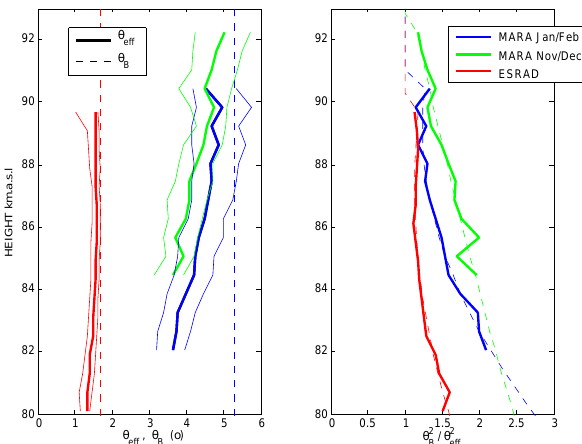
Fig. 1. Two-way antenna beam widths θ B (dashed lines), median (thick lines) and quartile (thin lines) height profiles of effective beam width θ eff (left-hand panel) and corresponding correction fac- /θ 2 tors θ 2 to be applied to the volume reflectivity calculations B eff (right-hand panel). Dashed lines in the left-hand panel are smooth curves fitted to the mean profiles of the correction factors. The fitted curves are used to correct reflectivities. See text for further